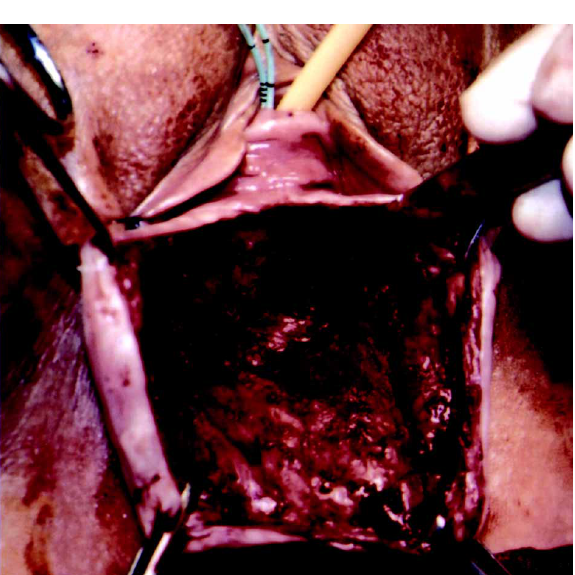
Figure 3 – After sling elevation, fascia lata is laterally attached to pubocervical fascia, and proximately attached to levator ani muscles.